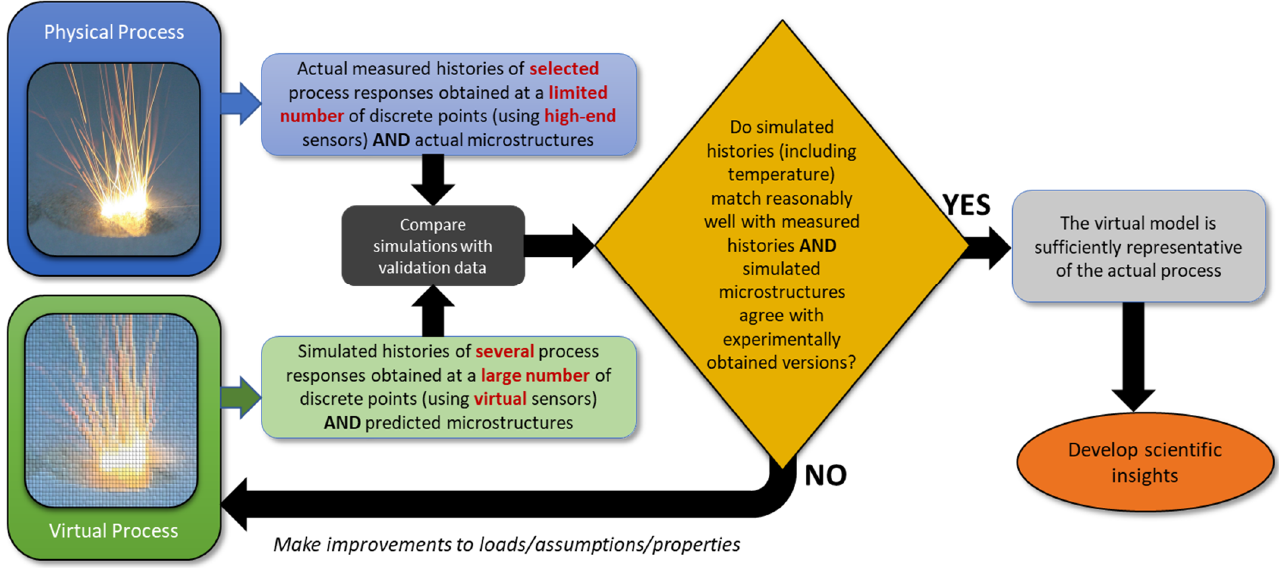
Figure 4. The nexus between experiments and simulations in advancing the knowledge on microstructure formation in AM processes. Temperature is widely accepted as a reliable process signature and its history must be measured and compared with predictions.